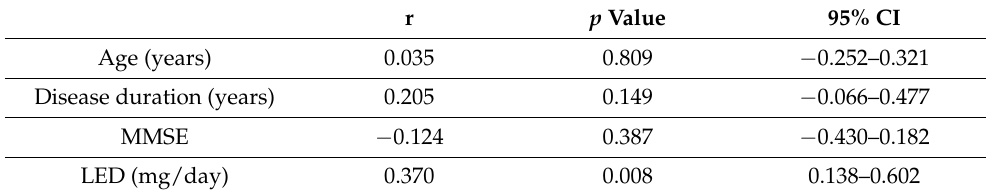
Table 3. Correlation analysis of the number of constipation symptoms and baseline